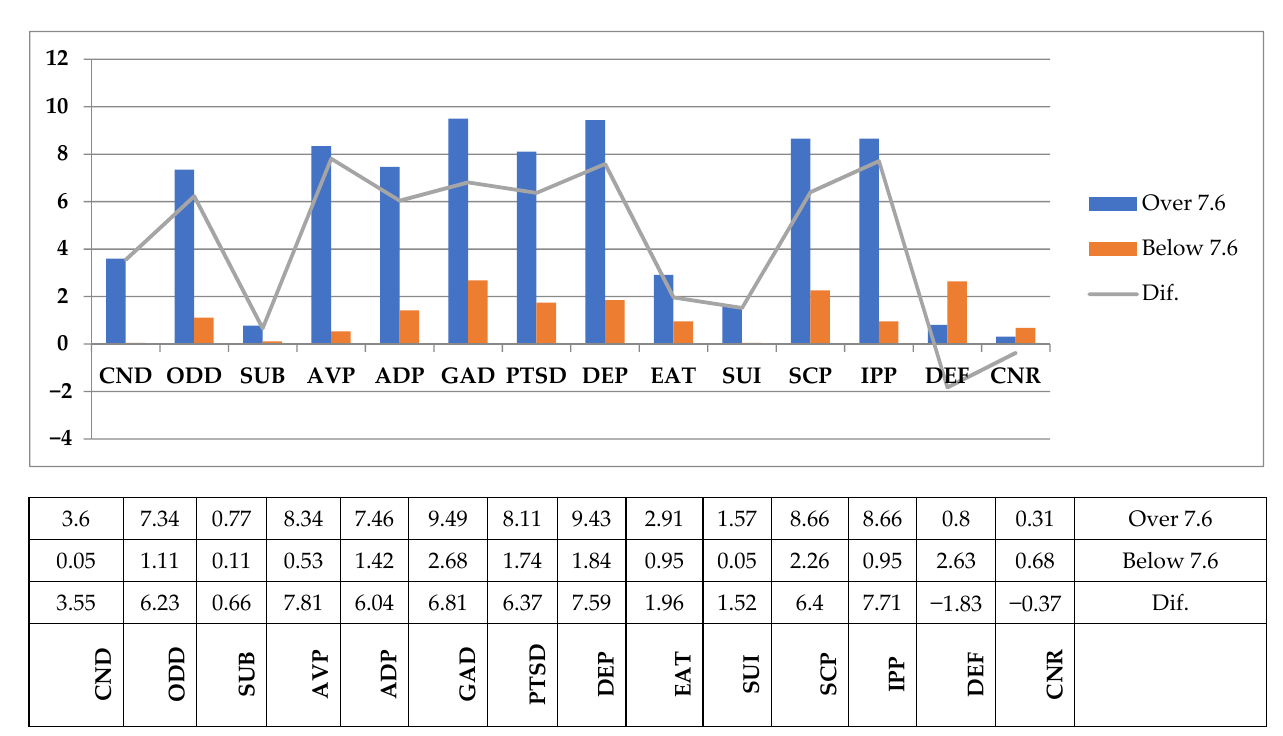
Figure 2. Media distribution of ASP–SF subscales in adolescents with IDD and high and low glycemic control. Legend: Conduct Disorder (CND), Oppositional Defiant Disorder (ODD), Substance Abuse Disorder (SUB), Anger/Violence Proneness (AVP), Academic Problems (ADP), Generalized Anxiety Disorder (GAD), Post-Traumatic Stress Disorder (PTSD), Major Depression (DEP), Eating Disturbance (EAT), Suicide (SUI), Self-Concept (SCP), Interpersonal Problems (IPP), Defensiveness (DEF), and Consistency Response (CNR). Table 2. Significant association between adolescents with psychiatric psychopathology and poor glycemic control.